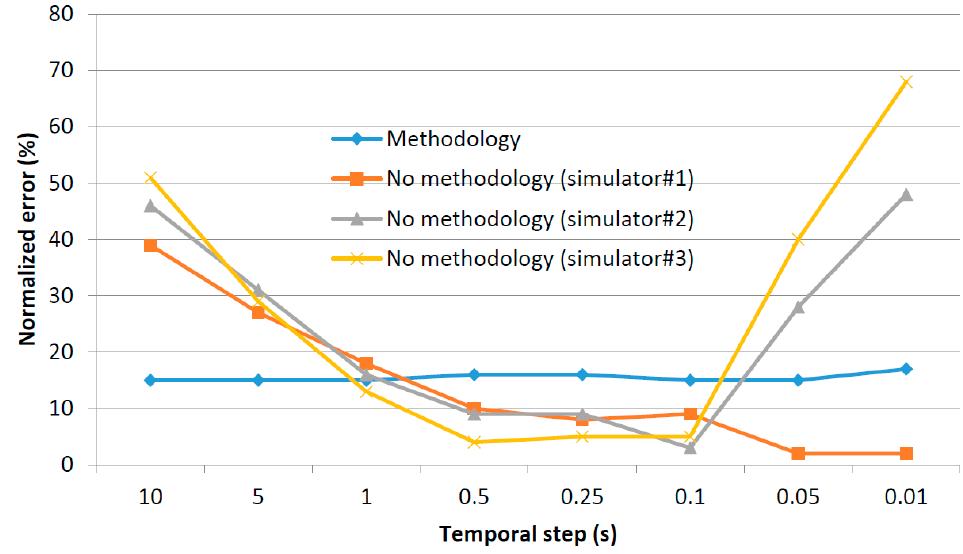
Figure 20. Accuracy of the proposed co-simulators.